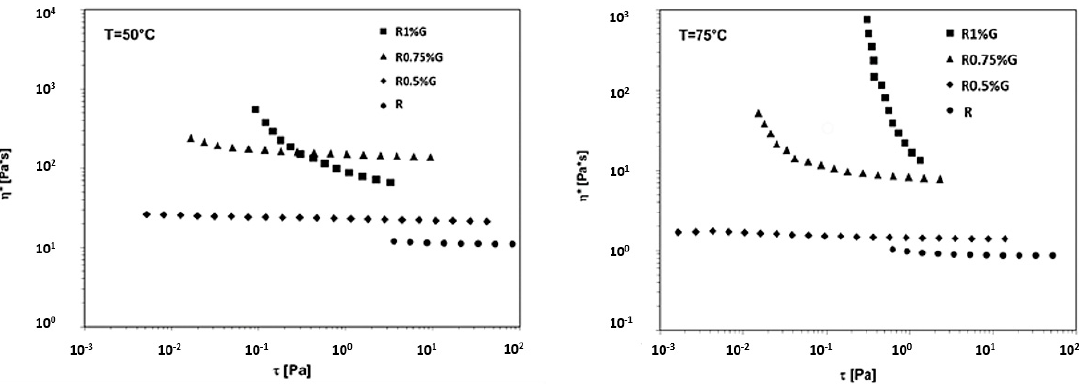
Figure 22. Complex viscosity vs shear stress at T = 50 °C and T = 75 °C for the R uncured epoxy matrix, the R0.5%G, R0.75%G and the R1%G by wt liquid dispersions.